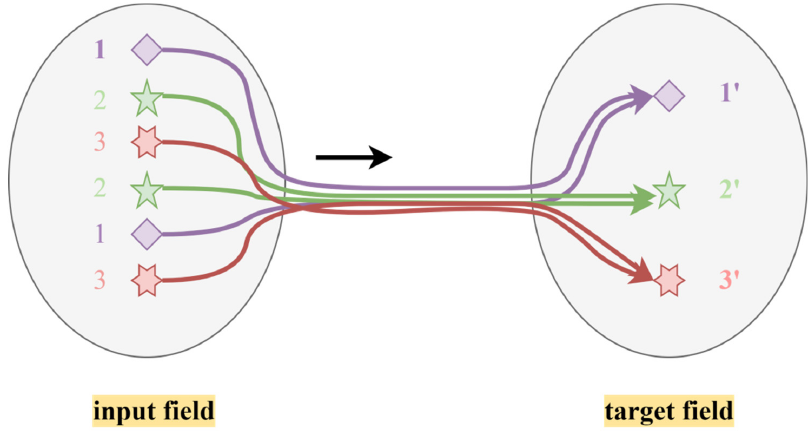
Figure 5. The discrete parallel processing circuit architecture.